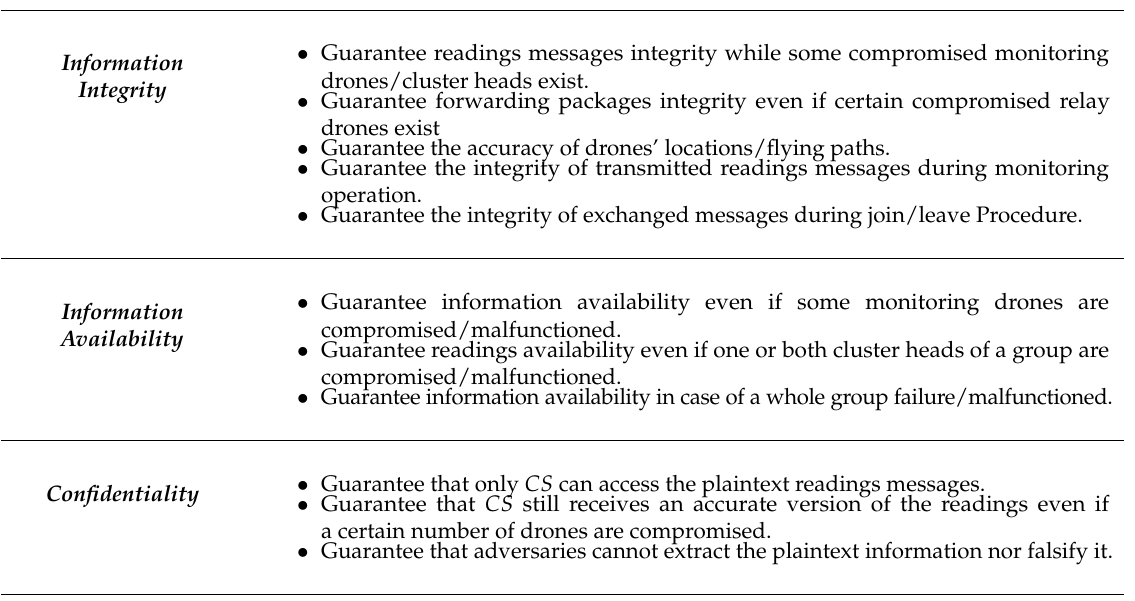
Table 1. The proposed scheme